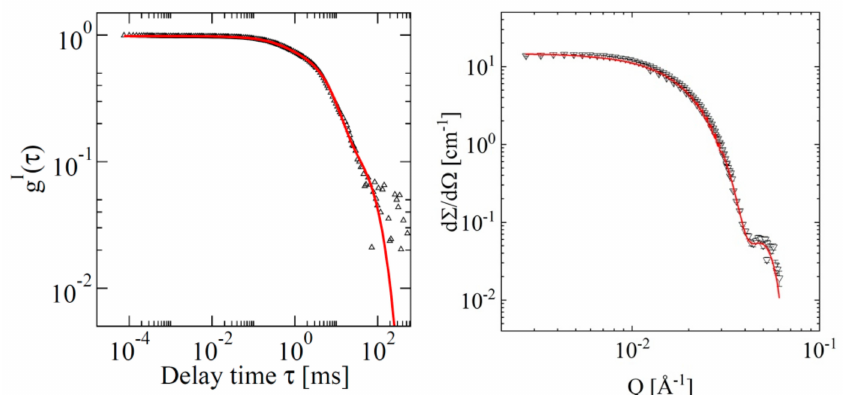
Figure 9. Left : the electrical field first-order correlation function g I ( τ ) obtained from the DLS measurement of the solution of silica nanospheres (with nominal diameter of 20 nm). The red line is a triple-exponential fit, identifying two decay times: 0.48 ms and 6.64 ms with considerable amplitudes and a third one with a comparably small amplitude which will be attributed to noise here. Right : the SANS cross section of the same solution (open symbols). The red line is the data fit based on the spherical form factor model (R ns = 11.9 nm) with polydispersity in size ( σ = 12%) and instrument resolution considered [15]. Although the SANS curve does not signal the presence of aggregates in the solutions, the DLS